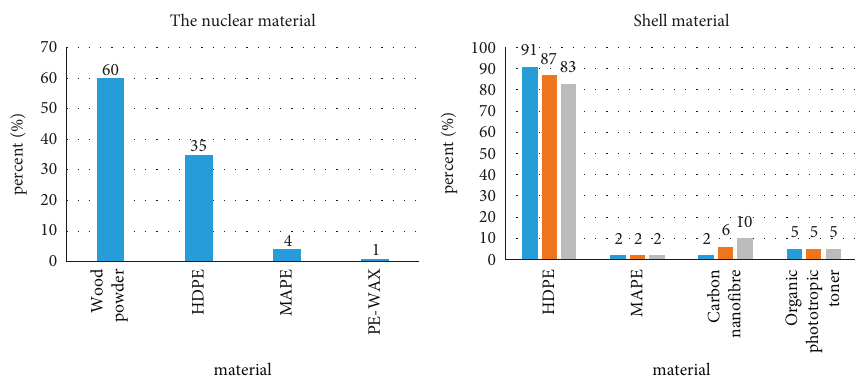
Figure 6: Composite material ratio